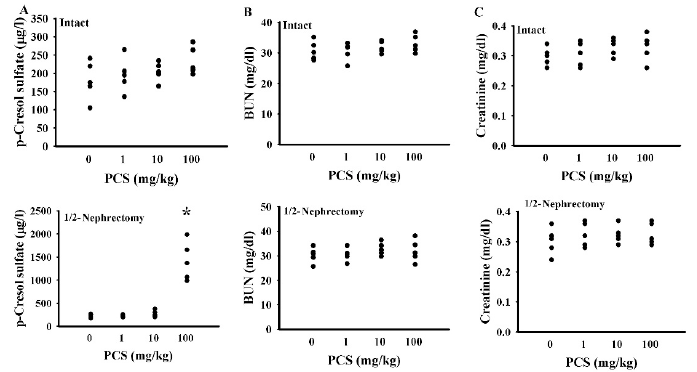
Figure 1. p-Cresol sulfate (PCS) administration caused PCS serum accumulation in nephrectomized mice. The intact and unilateral nephrectomized (1/2-Nephrectomy) mice were intraperitoneally injected with various doses of PCS for 7 weeks. The blood was collected and subjected to the measurement of PCS ( A ), blood urea nitrogen (BUN) ( B ), and creatinine ( C ). * p < 0.05 vs. control group without PCS, n = 5. Int. J. Mol. Sci. 2020 , 21 , x FOR PEER REVIEW